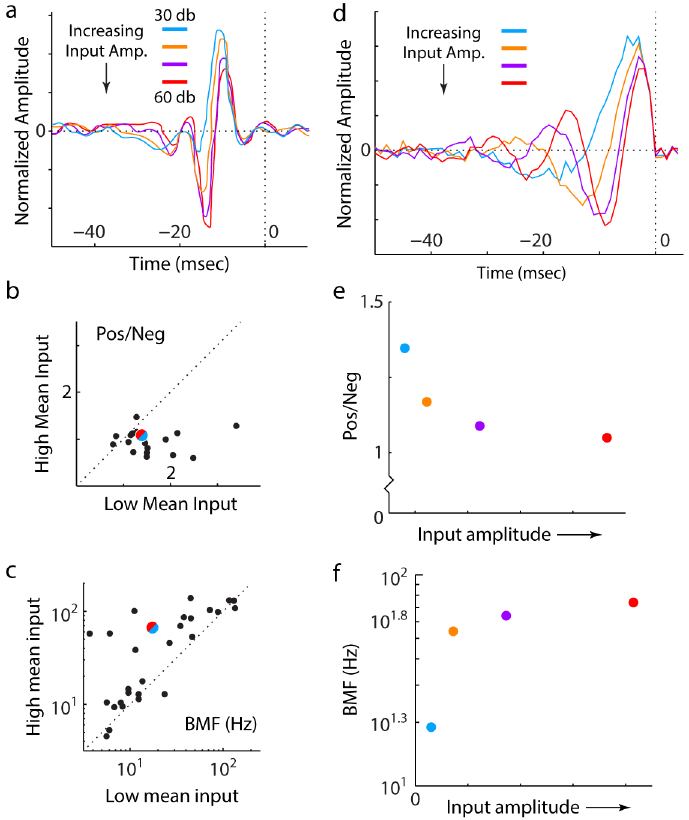
Fig 7. Response filters of zebra finch auditory neurons ((a), adapted from [28]) compared to theoretically simulated response filters of a nonlinear feedback inhibitory circuit (d). (a-c) Adapted from [28]. (a) Linear response filters for a single neuron stimulated with inputs of different mean sound amplitudes (colored to match (d)). (b) Ratio of the total positive to total negative component of neuronal filters is computed for an input with high mean amplitude, and an input with low mean amplitude. Each circle shows these values for a different recorded neuron (one example being (a)). The colored circle is derived from the simulated response filters of the principal cell of the nonlinear circuit (d). It uses the ratio of the total positive to total negative component of the simulated filters (plotted in (e)) at the highest input amplitude (red), and the lowest input amplitude (cyan). (c) The BMF (freq. of the peak of the Fourier transform of the linear response filters) for a high mean input, and a low mean input (for different neurons, one example being (a)). The colored circle is derived from the simulated responses of the principal cell of the nonlinear network (d). It uses the BMFs (shown in (f)) of the simulated filters at the highest input amplitude (red) and the lowest input amplitude (cyan). (d) Linear filters estimated to best approximate the response of the principal cell of the nonlinear circuit to white noise stimuli of different amplitudes (Methods). Curves colored to match (a). (e) The ratio of the total positive component of the curves in (d) to the total negative component. Points are colored as in (a, d). The ratios derived from inputs with highest (red) and lowest amplitude (cyan) define the colored circle in (b). (f) The BMF of the responses filters from (d). The BMF values derived from inputs with highest (red) and lowest amplitude (cyan) define the colored circle in